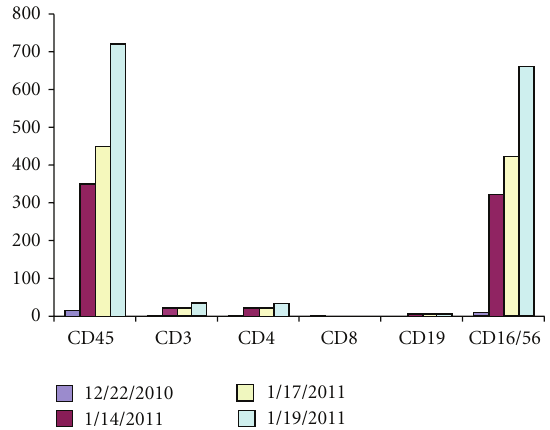
Figure 2: Serial T, B, and NK lymphocyte